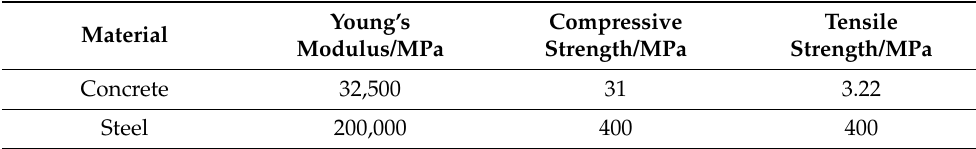
Table 3. Materials and strengths.